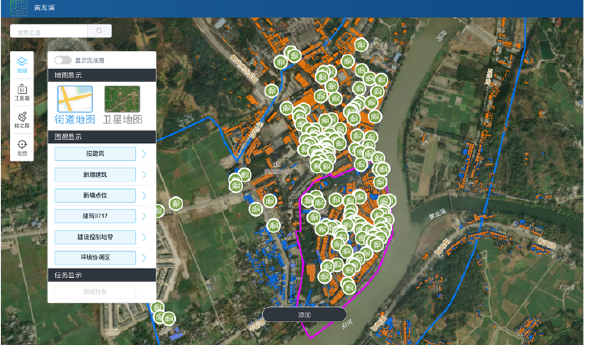
Figure 15 . Collection Results of Huanlgongxi Historic Town.